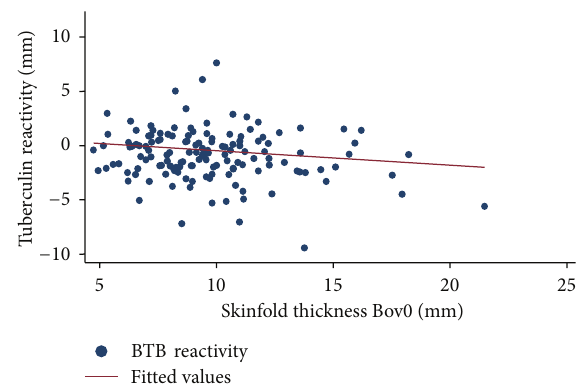
Figure 1: Scatterplot and regression line showing the relationship between BTB reactivity (( Bov 72 − Bov 0) − ( Av 72 − Av 0)) and intial skinfold thicknessat bovine site(Bov0) forall thedistricts( 𝑛 = 459 ). BTB reactivity was observed to decrease with increasing skinfold thickness. Skin fold thickness at the bovine site was negatively correlated with tuberculin